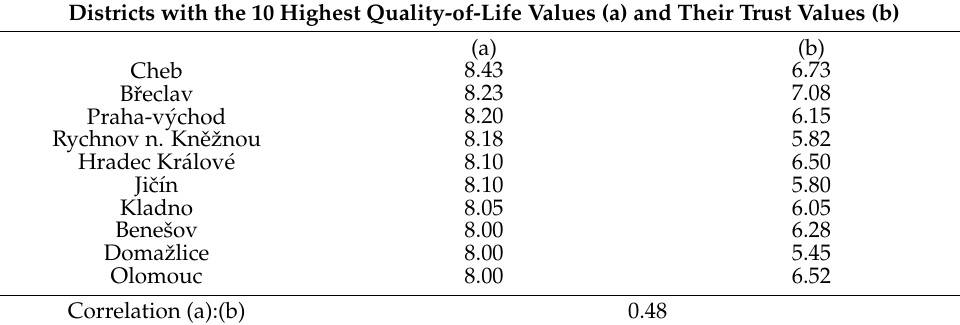
Table 4. Districts with the highest quality of life and corresponding trust